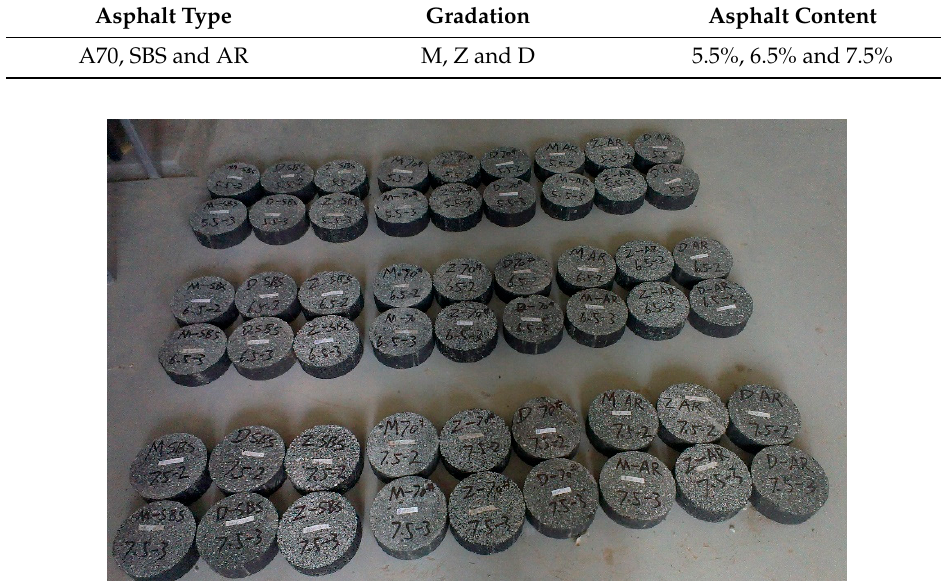
Figure 3. 27 AC-5 asphalt mixtures.